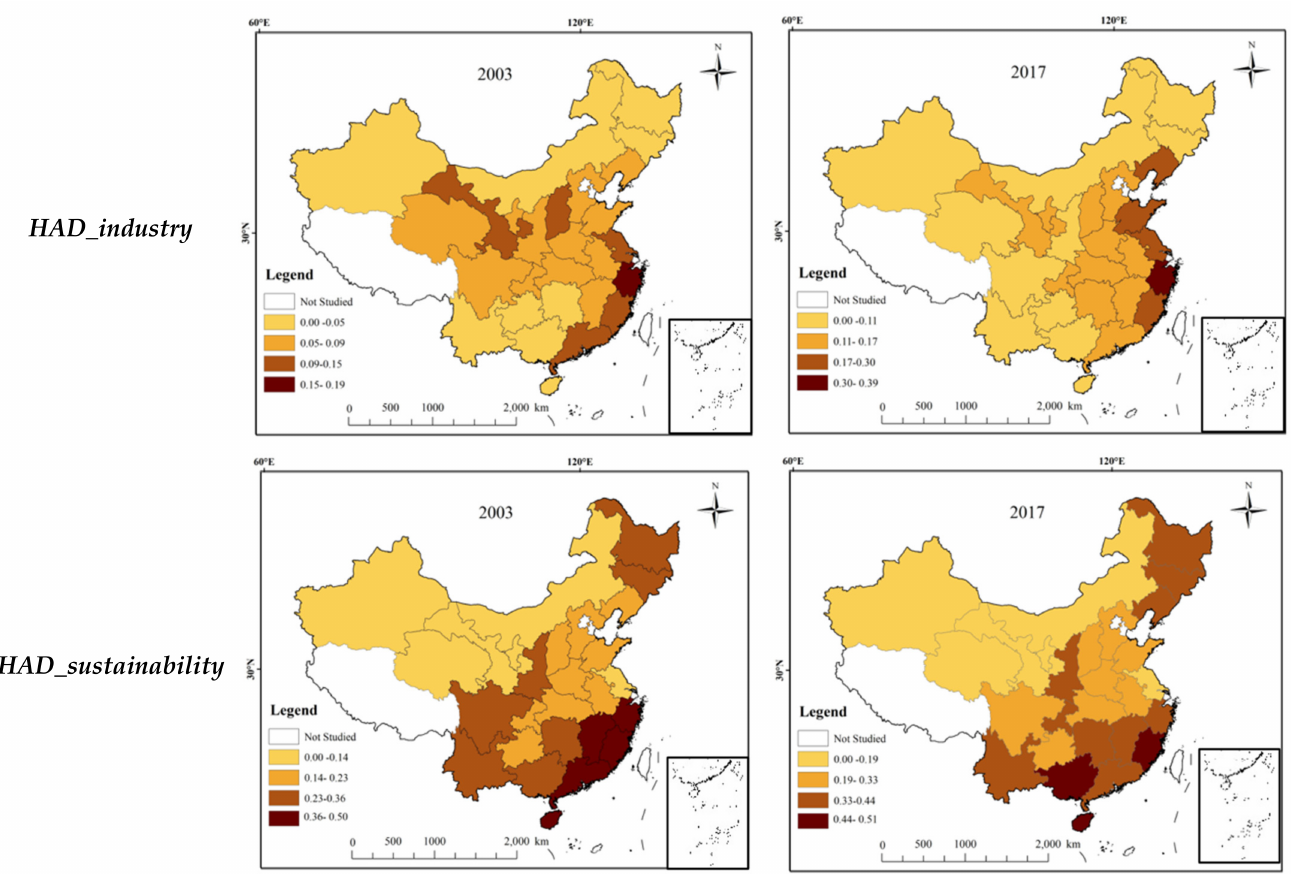
Figure 3. The evaluation results of HAD in 2003 and